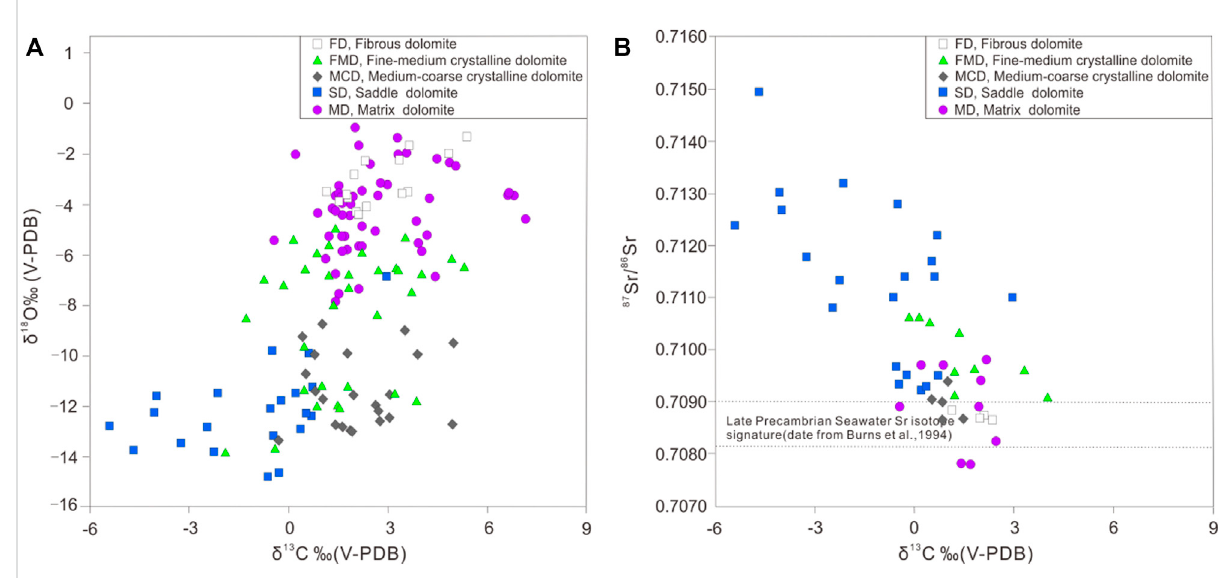
FIGURE 4 (A) Crossplotof δ 13 Cand δ 18 OfordifferentrockfabricsintheDengyingFormationofCentralSichuanBasin(FD,MCD,andSDdataarefromFeng et al., 2017; Su et al., 2022). (B) Crossplot of δ 13 C and 87 Sr/ 86 Sr for different rock fabrics in the Dengying Formation of Central Sichuan Basin ( 87 Sr/ 86 Sr data for FD, MCD, and SD are from Feng et al., 2017; Su et al., 2022; 87 Sr/ 86 Sr data for late Precambrian seawater are from Burns et al.,